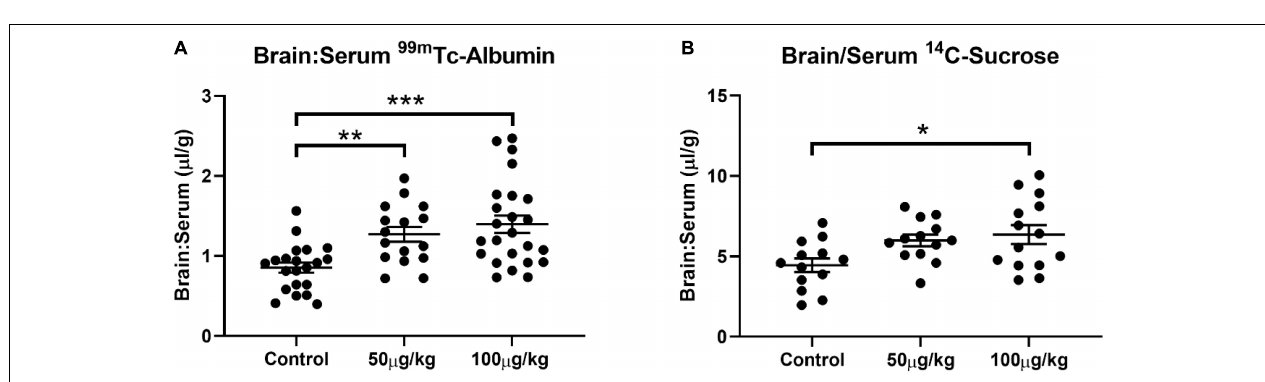
FIGURE 2 | NG291 disrupts the BBB in a dose and time-dependent fashion. The area occupied by Evans blue is in proportion to the total brain area. In (A,B) , male Sprague Dawley (SD) rats were used. Female SD rats were used in (C) . SD rats were administered 50 µ g/kg of NG291 (i.v.) in (A) . SD rats were administered 100 µ g/kg of NG291 (i.v.) in (B,C) . Time periods in X -axis represent the time intervals between NG291 and Evans blue (2 ml/kg) injection. EB circulated overnight, and then the brains were harvested, sectioned, and imaged. (Data are presented as mean ± SEM). * p < 0.05, ** p < 0.01, *** p < 0.001.